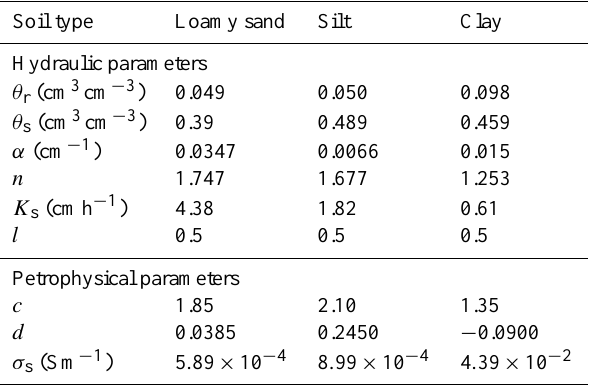
Table 1. Van Genuchten’s hydraulic parameters and Rhoades’s petrophysical parameters for the loamy sand, silt and clay